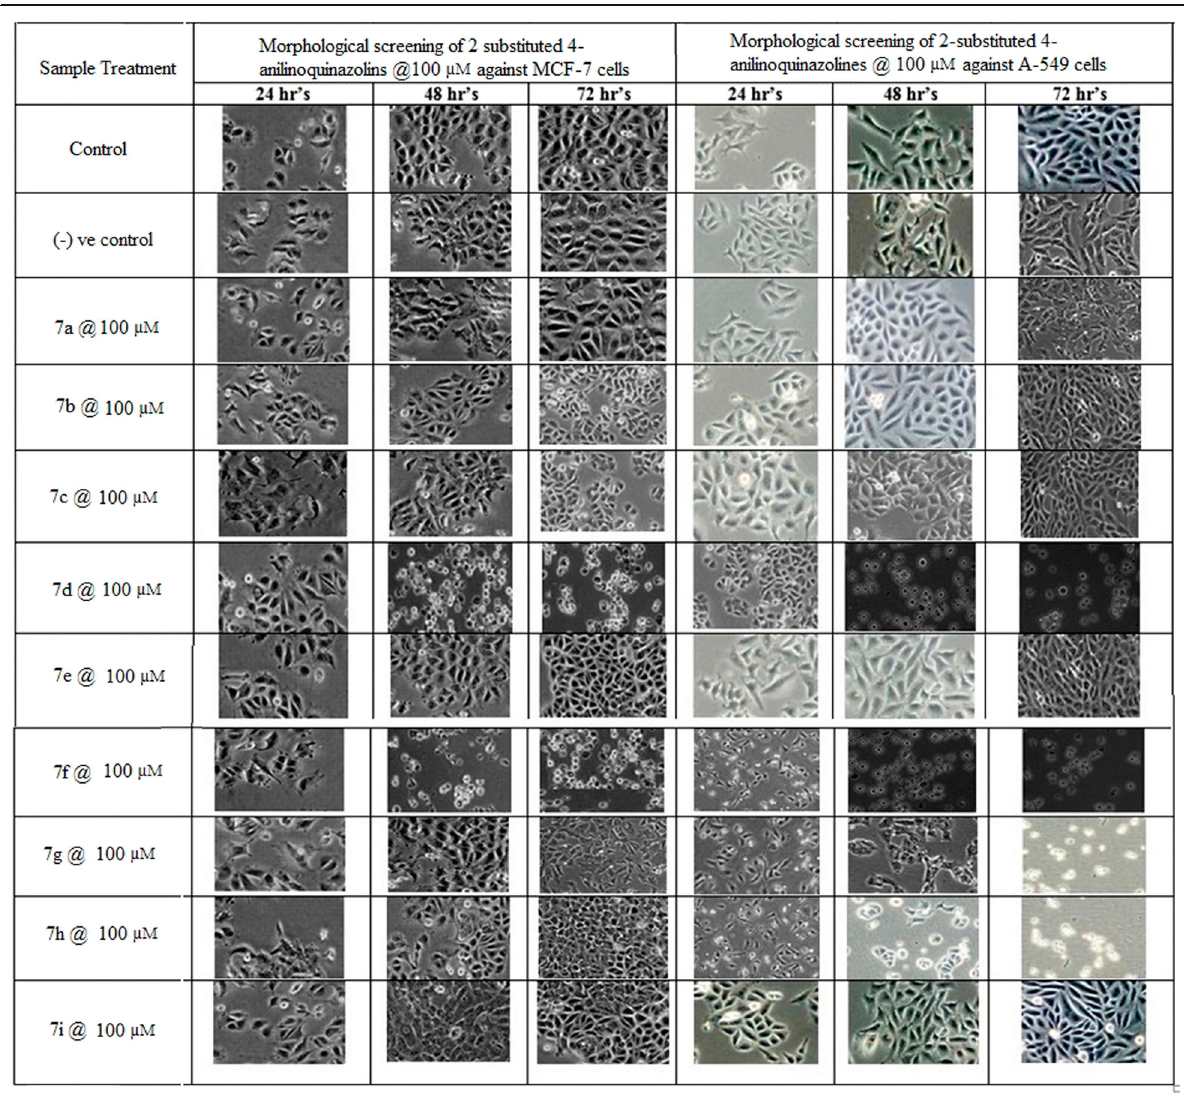
Fig. 2 Morphological assessment of synthesized compounds